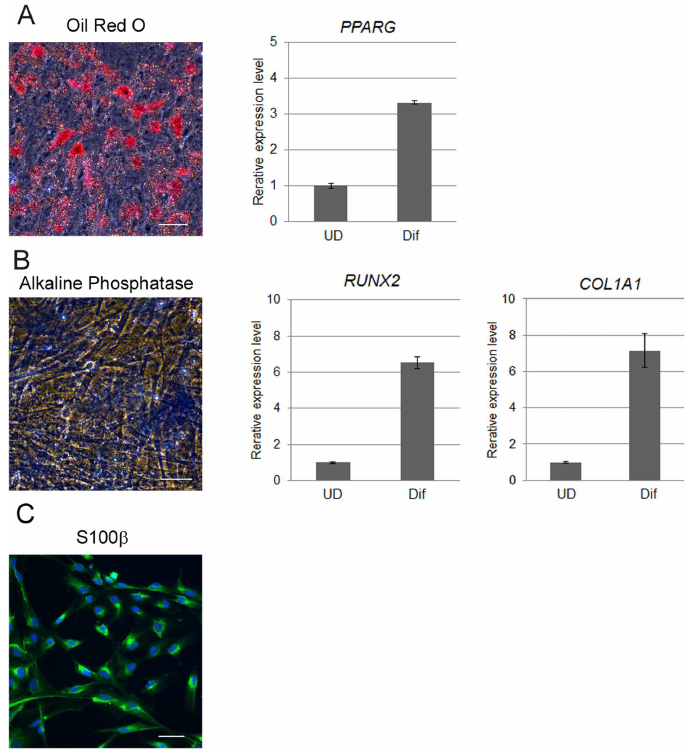
Fig 5. hiPSCs-derived SKPs display multipotency similar to traditionally isolated SKPs. (A) Adipogenic differentiation of hiPSC-SKPs was confirmedby Oil Red-O stainingand the up-regulation of PPAR γ gene expressionby qPCR. (B) Osteogenic differentiation was confirmedby ALP staining and the up-regulation of RUNX2 and COL1A1 geneexpressionby qPCR. (C) Differentiated Schwanncell lineageswere detected by S100 β staining.Scale bars, 50 μ m. UD: undifferentiated hiPSC-SKPs, Dif: